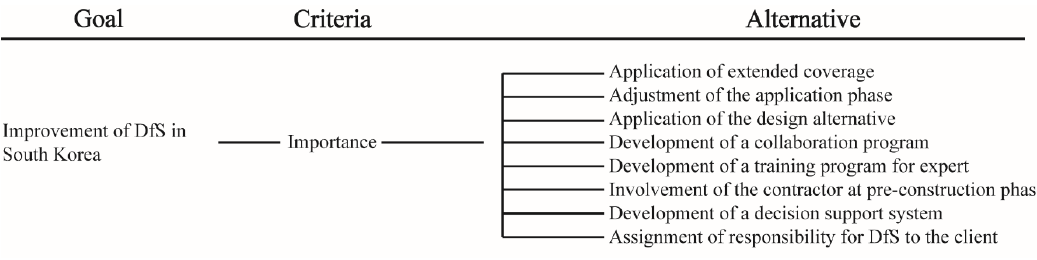
Figure 2. Result of absolute importance of alternatives.